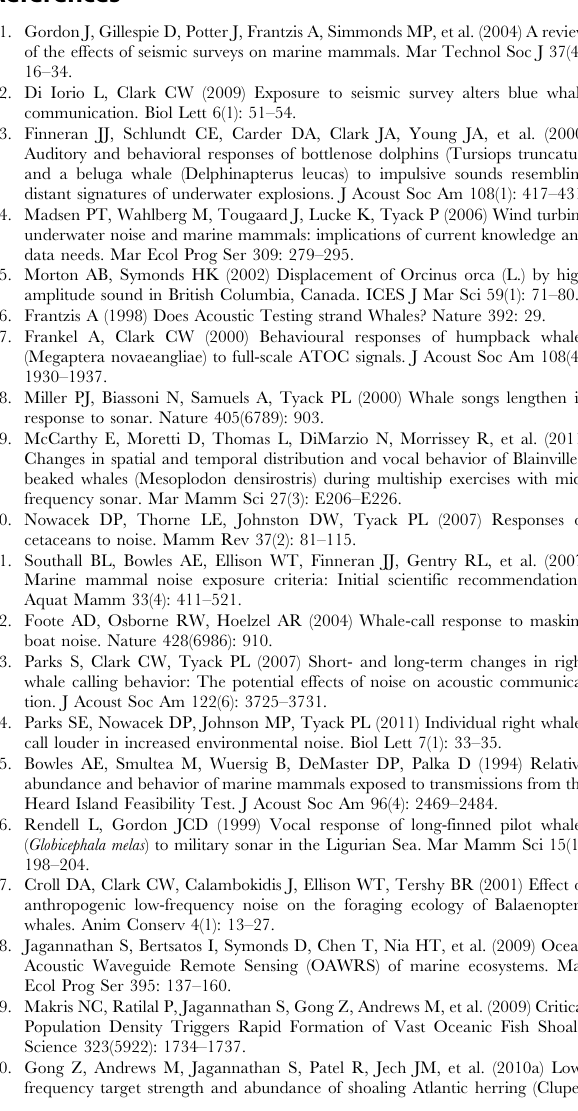
Figure S4 Time series of minutes with humpback whale song detections in September/October 2009. Plot is split in three panels representing time periods equal to (a) ‘Before’, (b) ‘During’ and (c) ‘After’ periods in 2006. Right y-axis displays date. Figure S5 (a) Plot of residuals of quasi-poisson GLM model for OAWRS data. (b) Temporal autocorrelation plot based on residuals of quasi-poisson GLM model used in OAWRS analysis. Blue dashed line indicates approximate 95% confidence interval.